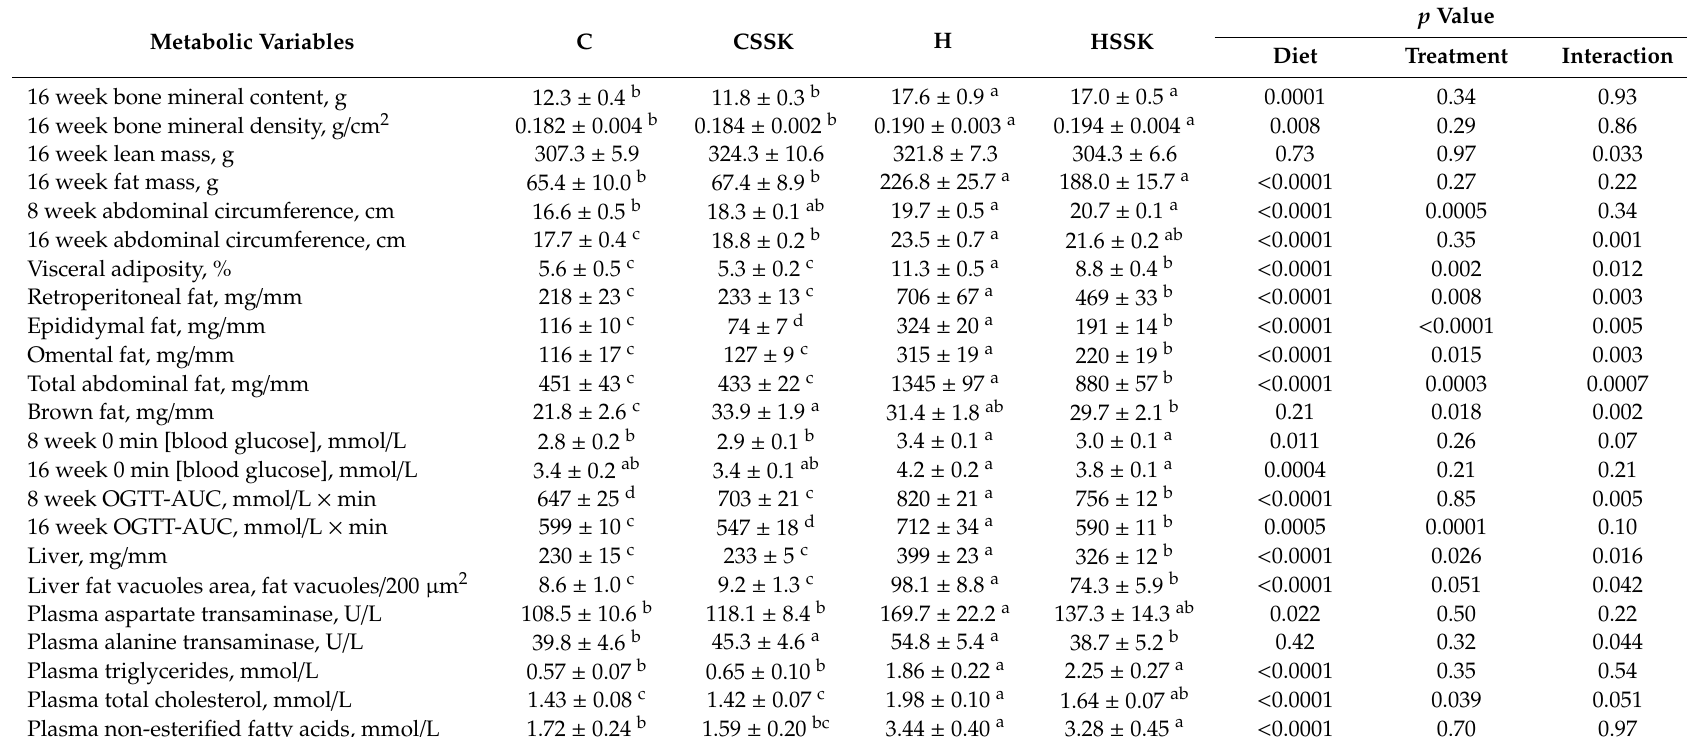
Table 2. Metabolic responses to Saskatoon